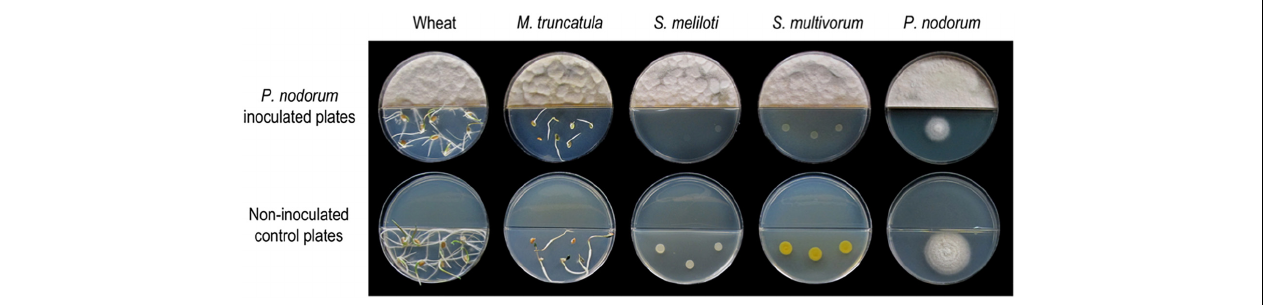
FIGURE 1 | Split plate assays of the effect of VOCs produced by wild type P. nodorum (SN15). The top row of plates show the inhibition caused by P. nodorum VOCs on wheat and Medicago seeds, S. meliloti, S. multivorum, and P. nodorum . The bottom row of plates shows the growth of each of the test organisms in the absence of P. nodorum